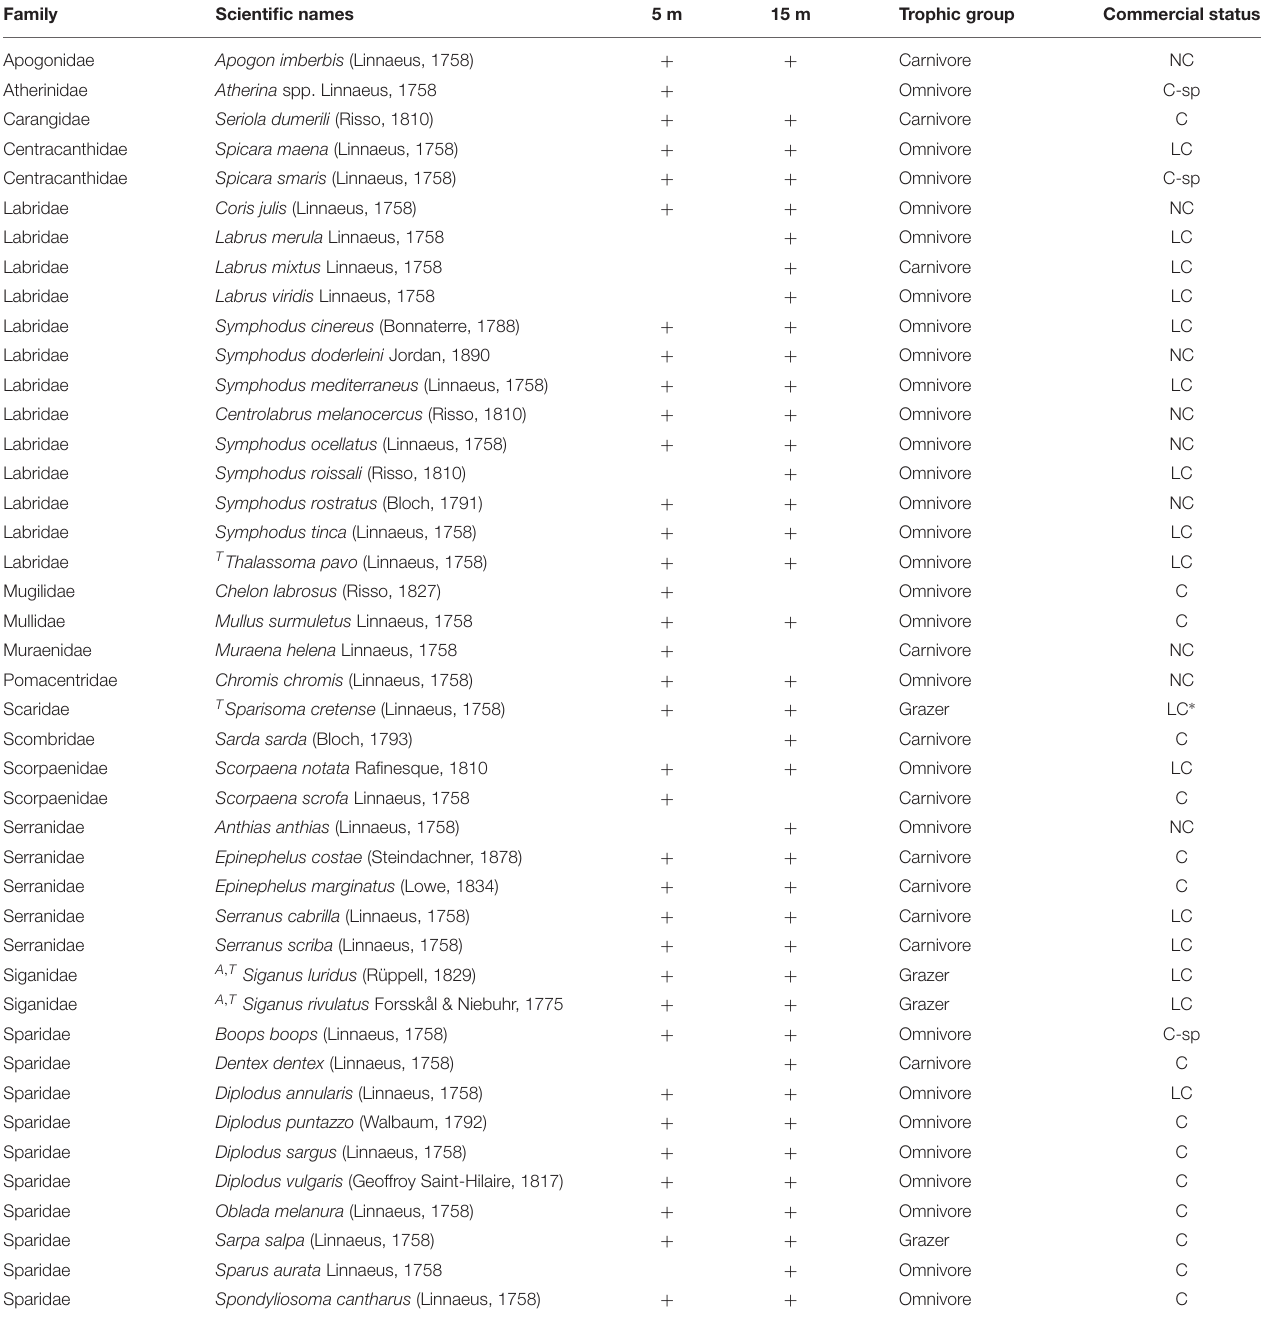
TABLE 1 | Fish species recorded in the Aegean Sea at 5 and 15 m depth zones, their trophic group and commercial status.